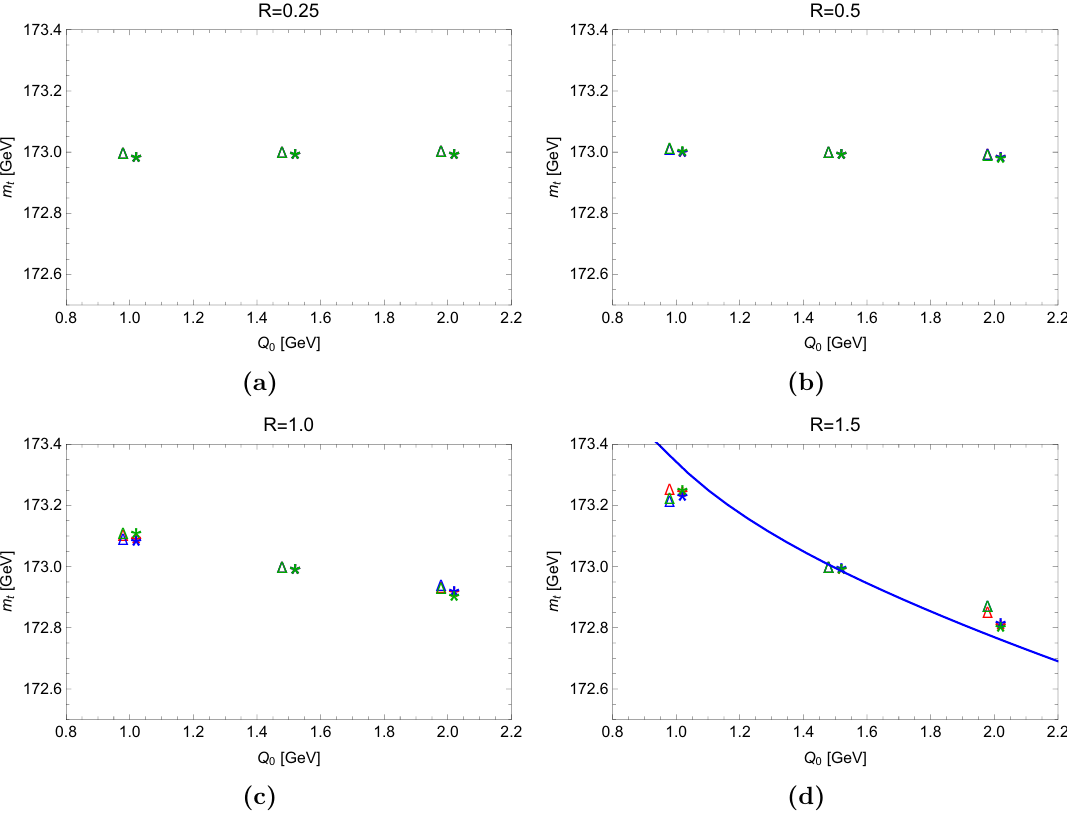
endpoint (stars) j ‘